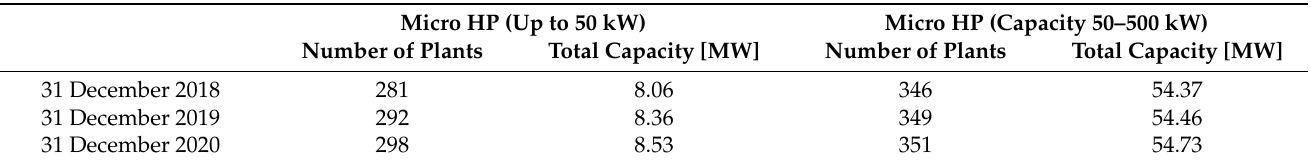
Table 10. Investments in micro and small hydropower plants in years